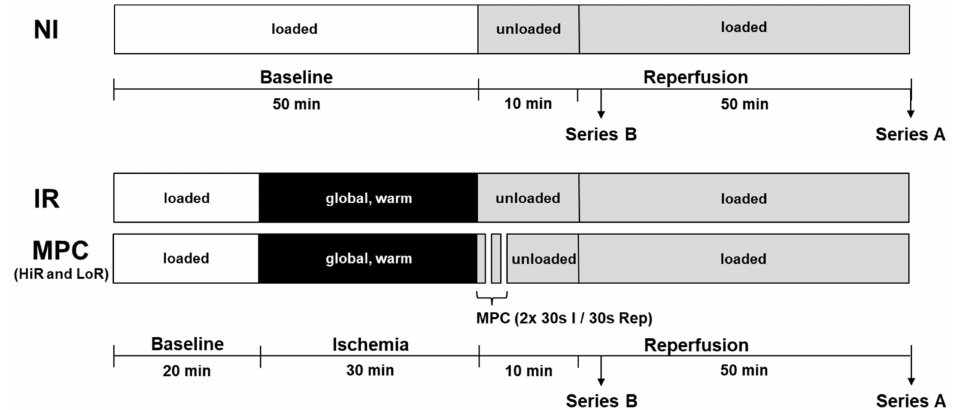
Figure 8. Experimental protocol. Hearts underwent 20 min of baseline, working-mode